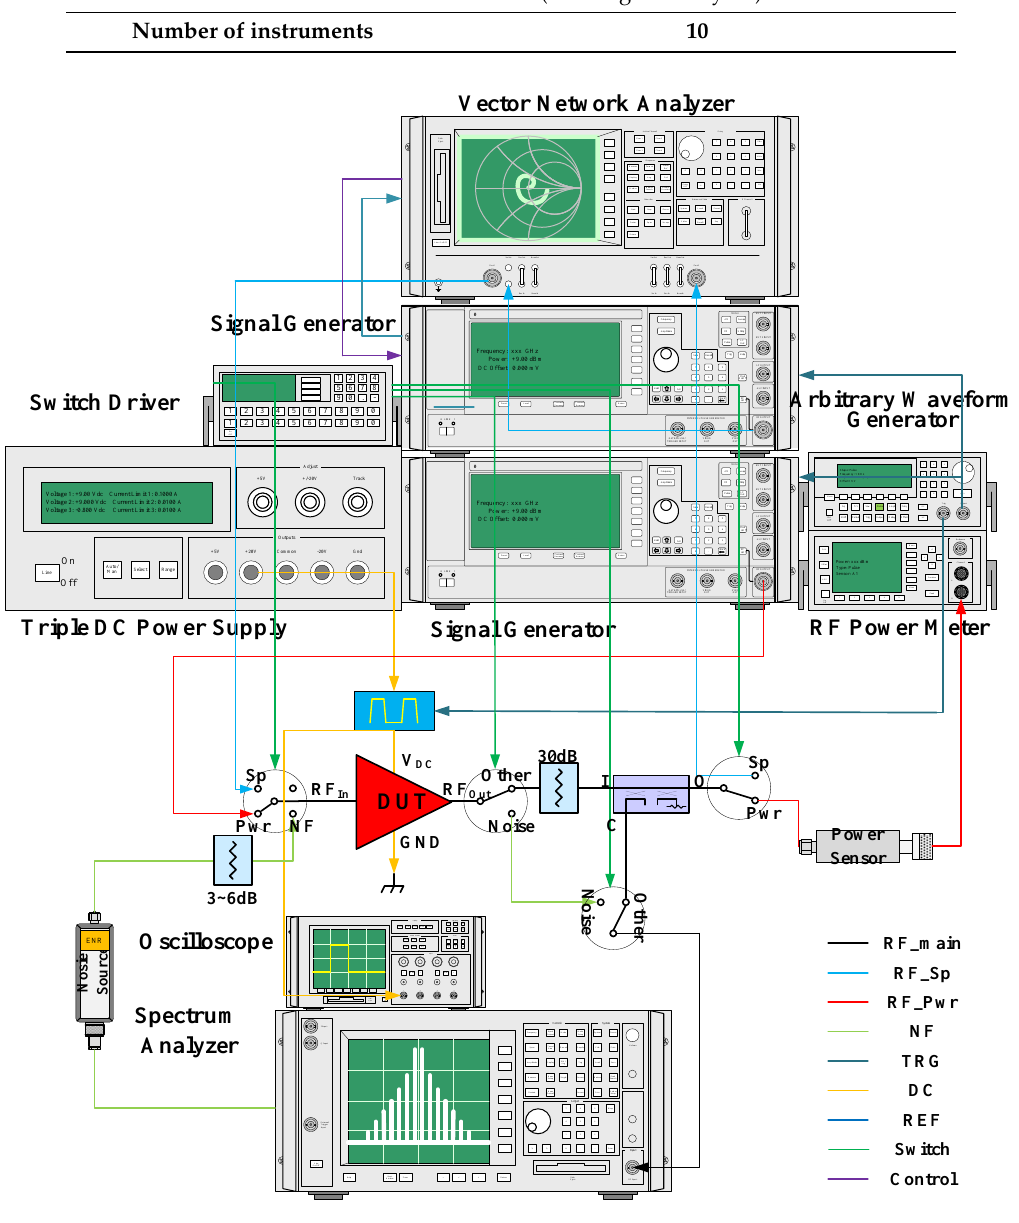
Figure 1. The traditional test system.